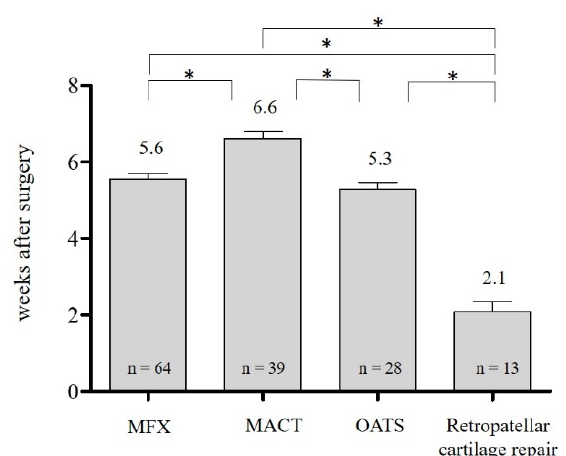
Figure 6. Weeks until release of FWB after surgical cartilage repair of the knee joint. MFX: microfrac- turing; MACT: matrix-assisted cartilage transplantation; OATS: osteochondral autograft transfer system. * p ≤ 0.001. system. * p ≤